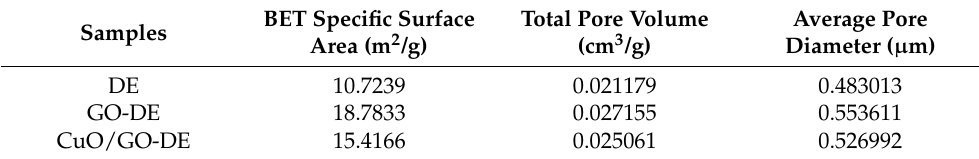
Table 1. BET measurement results of DE, GO-DE and Cu/GO-DE. BET Specific Samples